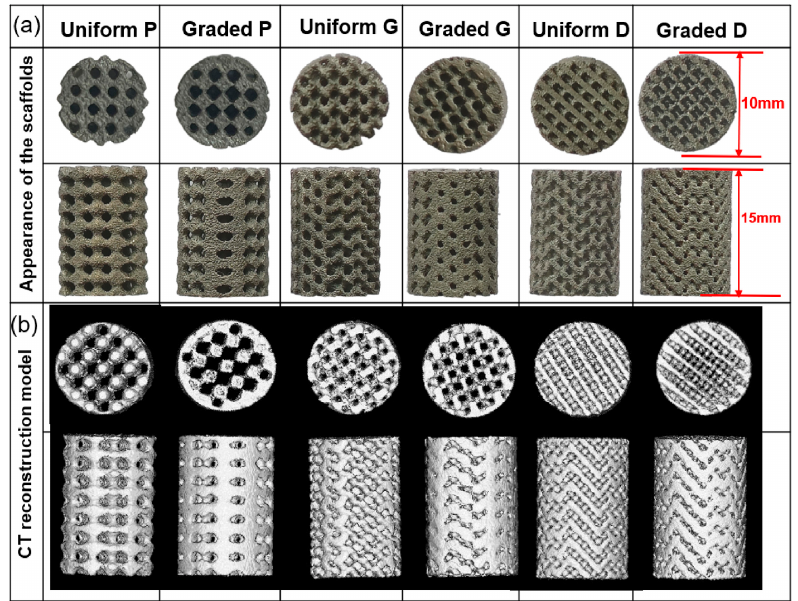
Figure 14. Titanium alloy bone scaffold. ( a ) Macroscopic feature image of the scaffolds, ( b ) scaffolds model image obtained by micro-CT. Reprinted with permission from Ref. [182]. Copyright 2022, copyright Lv Y, Wang B, Liu G.